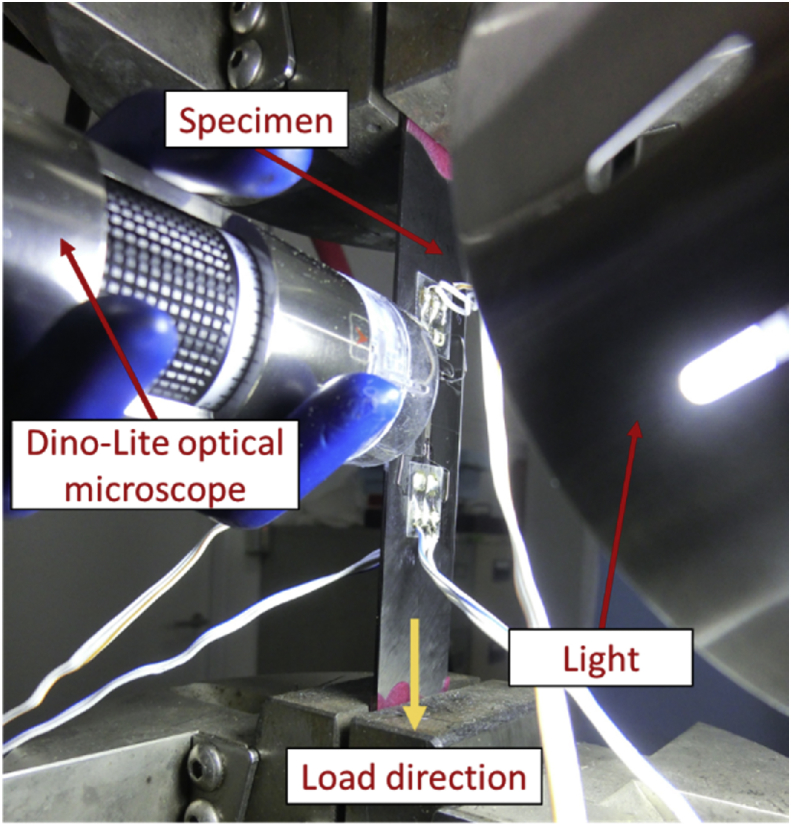
Experimental setup.